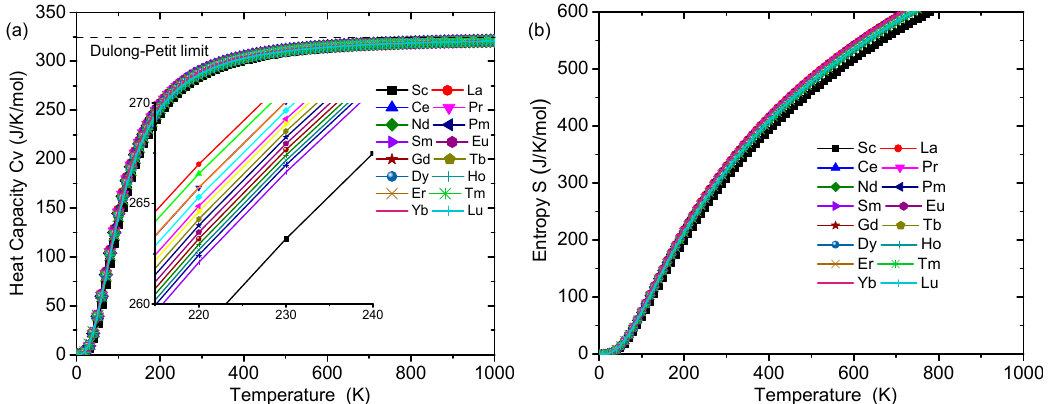
Figure 5. The ( a ) heat capacity and ( b ) entropy of Al 8 Fe 4 RE (RE = Sc, La–Lu) IMCs.